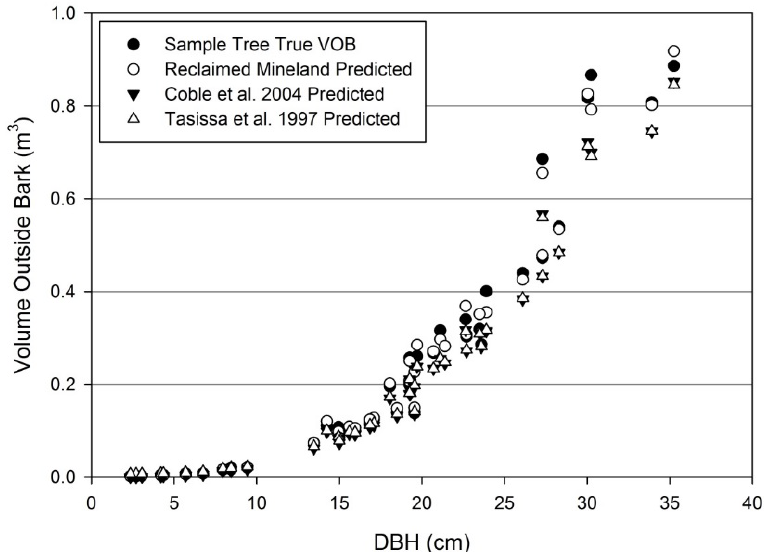
Figure 7. Individual tree volume outside bark in comparison to predicted values from the reclaimed mineland model and unmined